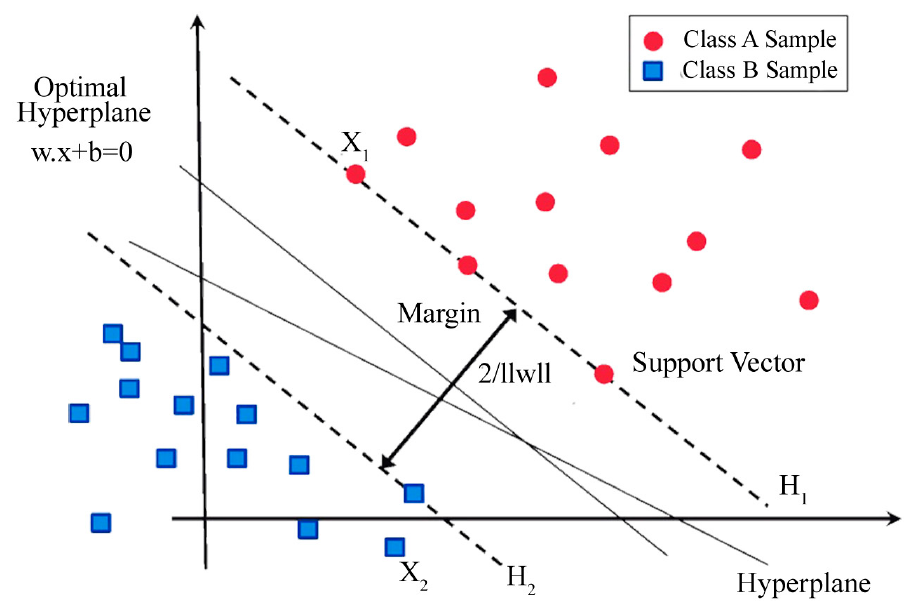
Figure 3. Data classification and support vectors.